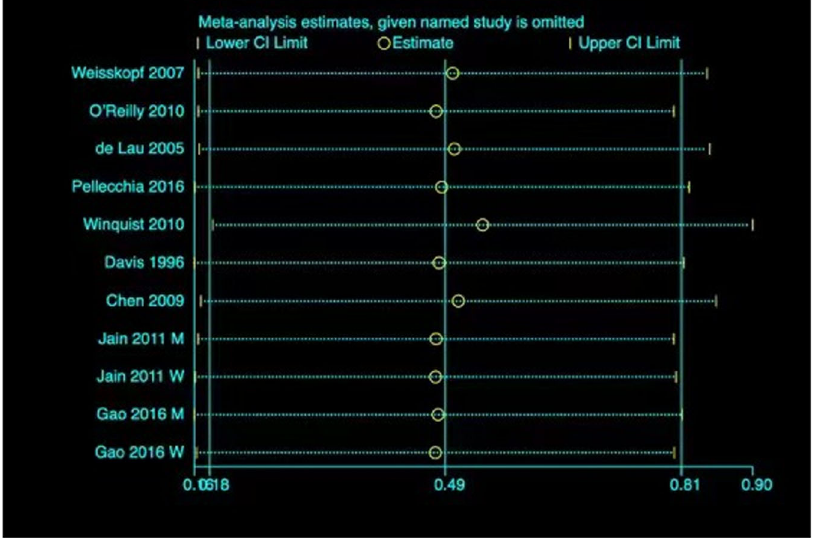
Fig. 3 Sensitivity analysis omitting one article in turn from the analyses on the correlation between high urate concentration and PD risks. The vertical lines show the summary estimate (0.49) and its 95% CI (0.18 – 0.81) from the meta-analysis of all the